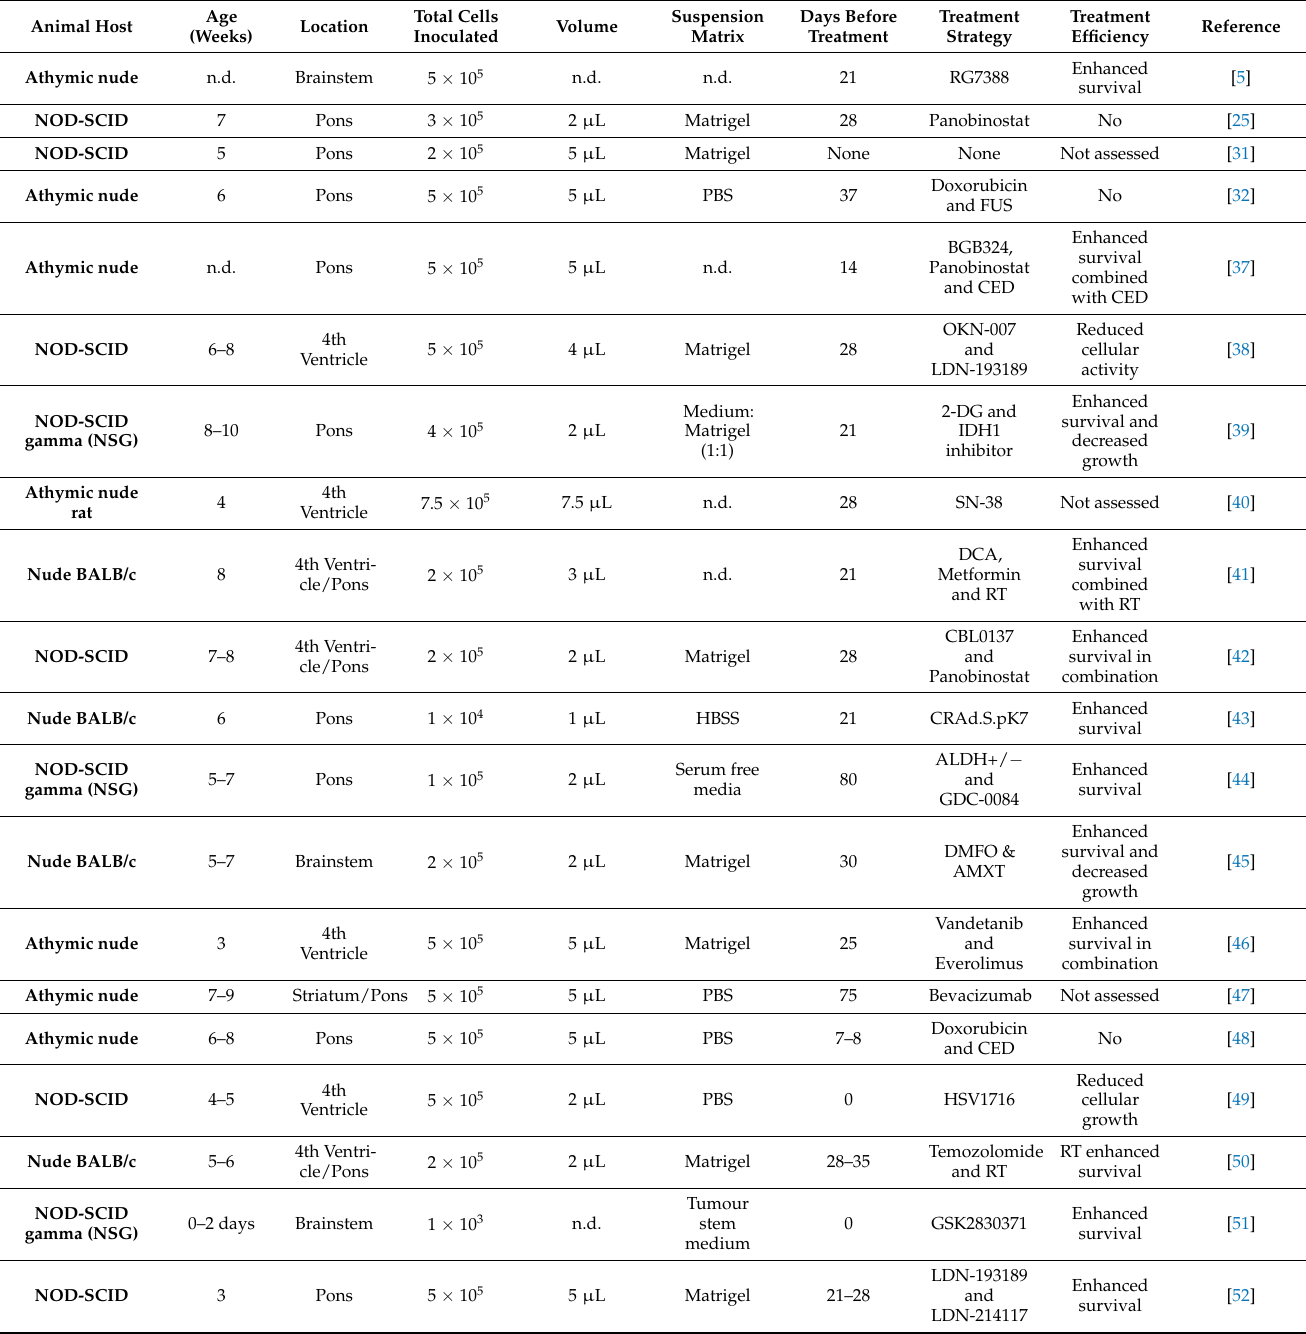
Table 1. Summary of studies using HSJD-DIPG-007 for establishing a DMG PDX model from 2016 to